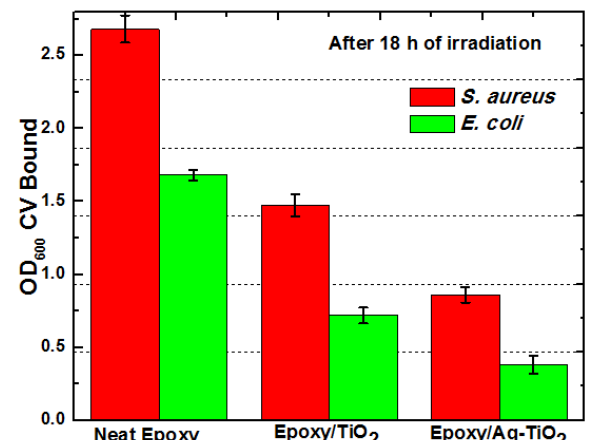
Figure 6. Spectrophotometric analysis (OD 600 ) of solubilized crystal violet of E. coli and S. aureus biofilm at 18 h irradiation time on the surfaces of TiO 2 and Ag-TiO 2 composite with similar loading (1